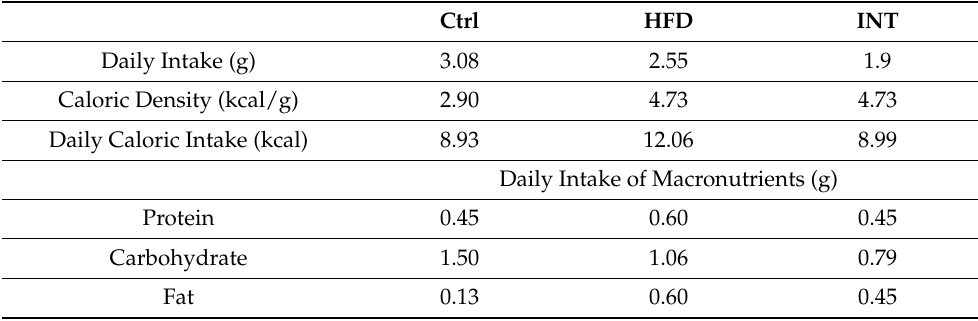
Table 3. Daily caloric and macronutrient intake of the different experimental groups. Ctrl HFD INT Daily Intake (g)